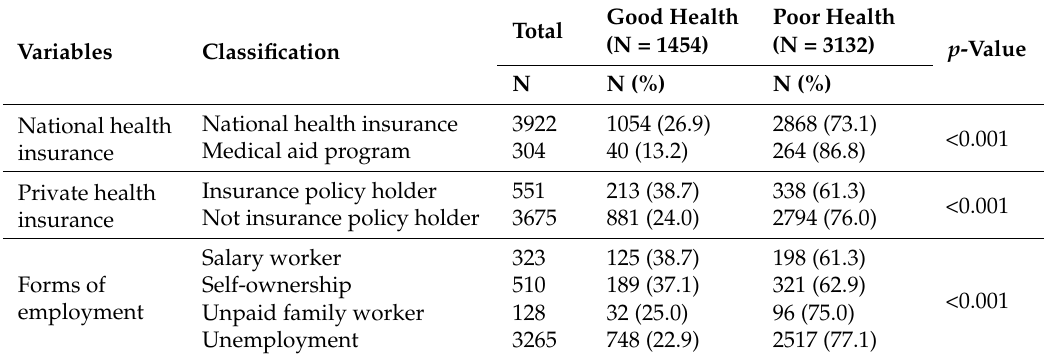
Table 2. Economic activity and health condition.